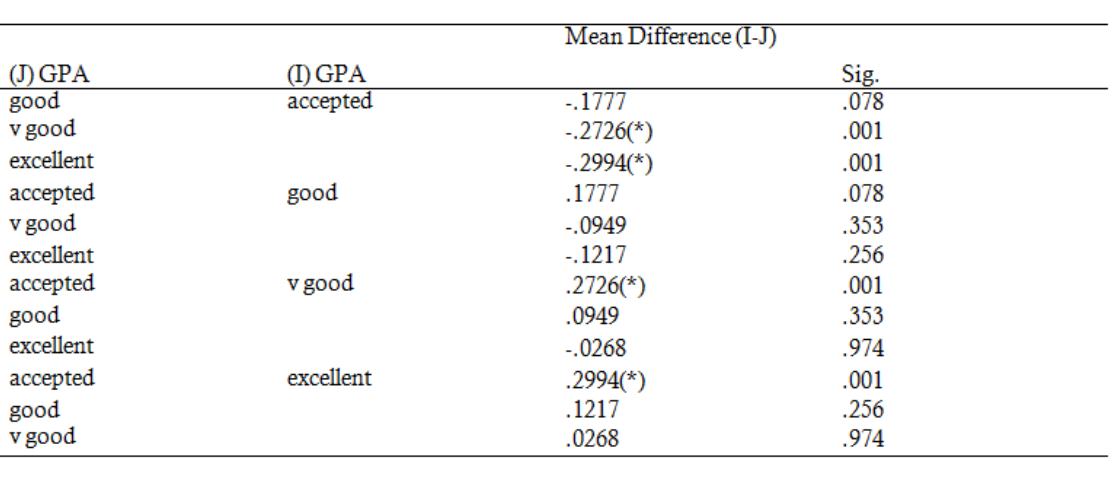
Table 8. Scheffe’s